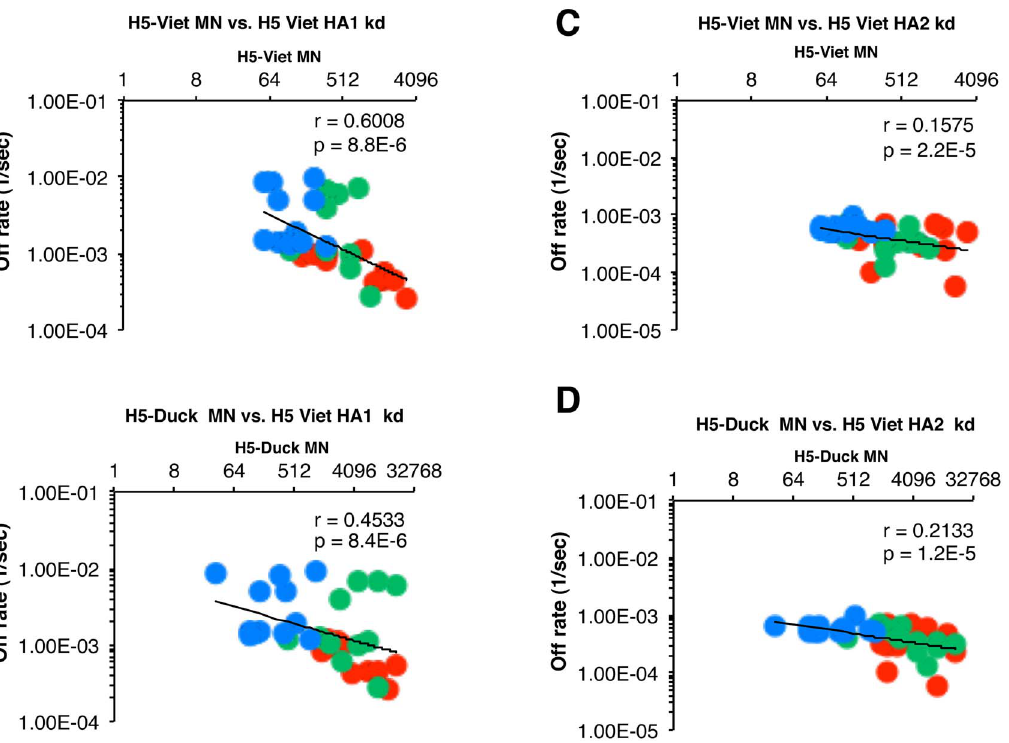
Figure 4. Serum antibody off-rates to H5-Viet-rHA1 (but not rHA2) following heterologous prime-boost strongly correlate with the in-vitro neutralizing capacity against the homologous H5 vaccine viruses. Antibody off-rate constants were determined directly from the plasma sample interaction with H5N1 rHA1 or rHA2 protein using SPR in the dissociation phase. SPR analysis of post-boost vaccination human sera from all vaccine groups included in the vaccine trial was performed with rHA1 (A and B) or rHA2 (C and D) of the H5N1- A/Vietnam/1203/2004 strain. Each symbol represents one individual. Serum samples on day 21 following single H5N1 booster vaccination from the MF59-H5N3 adjuvanted primed (red symbols) or unadjuvanted H5N3 primed (green symbols) or after two MF59-H5N1 vaccinations in the unprimed control (blue symbols) vaccine group is shown. Antibody affinity of post-H5N1 vaccinated human sera against HA1 (but not HA2) of H5N1- A/Vietnam/1203/2004 correlated with the homologous MN titers against the A/Vietnam/1203/2004 (H5N1) booster vaccine virus (A) as well as A/duck/Singapore/1997 (H5N3) priming vaccine virus (B).